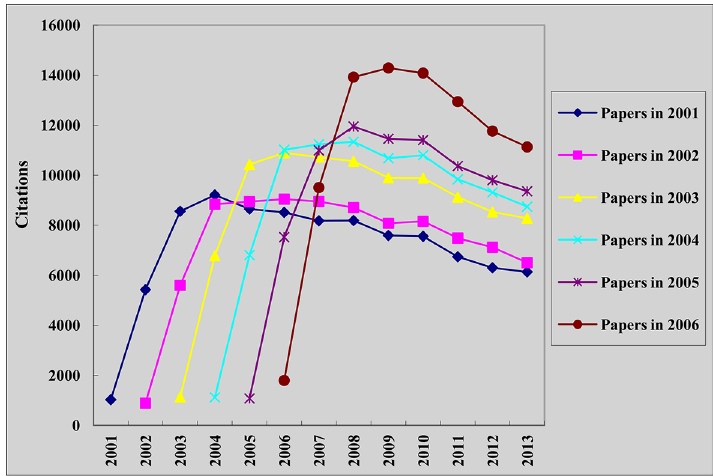
Fig 2. Citation evolution trends for papers published each year between 2001 and 2006 in 28 ophthalmologic journals.